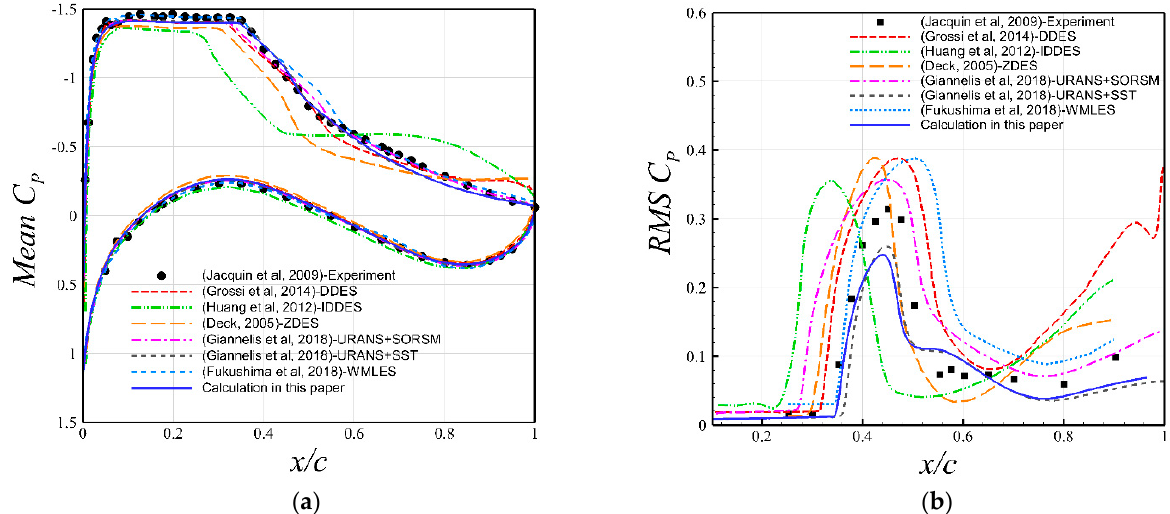
Figure 4. Comparison of mean and RMS pressure between the calculated results and observed in the experiments of [40] and numerical studies of [8,18,41–43]. Figures created by the authors using the data from the aforementioned publications. ( a ) Mean pressure coefficient. ( b ) RMS pressure